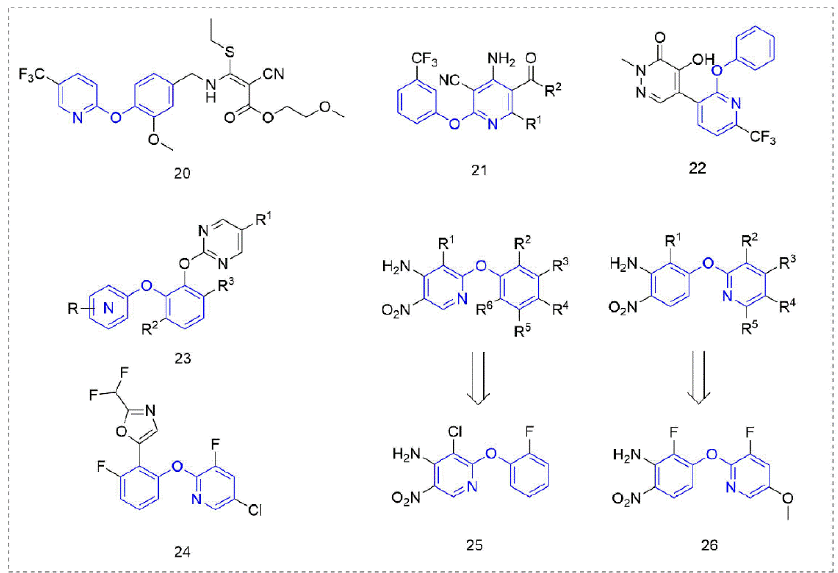
Figure 5. Other compounds with herbicidal activity containing